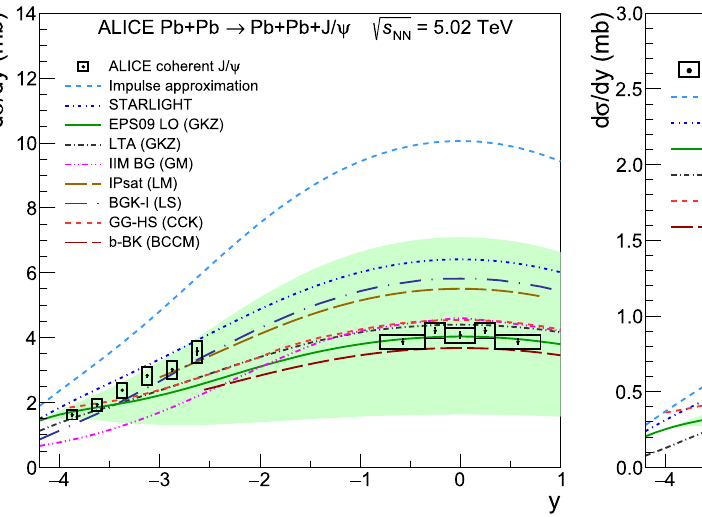
Fig. 6 Measured differential cross section of the coherent J /ψ (left) and ψ (cid:2) (right) photoproduction in Pb–Pb UPC events. The error bars (boxes) show the statistical (systematic) uncertainties. The theoretical